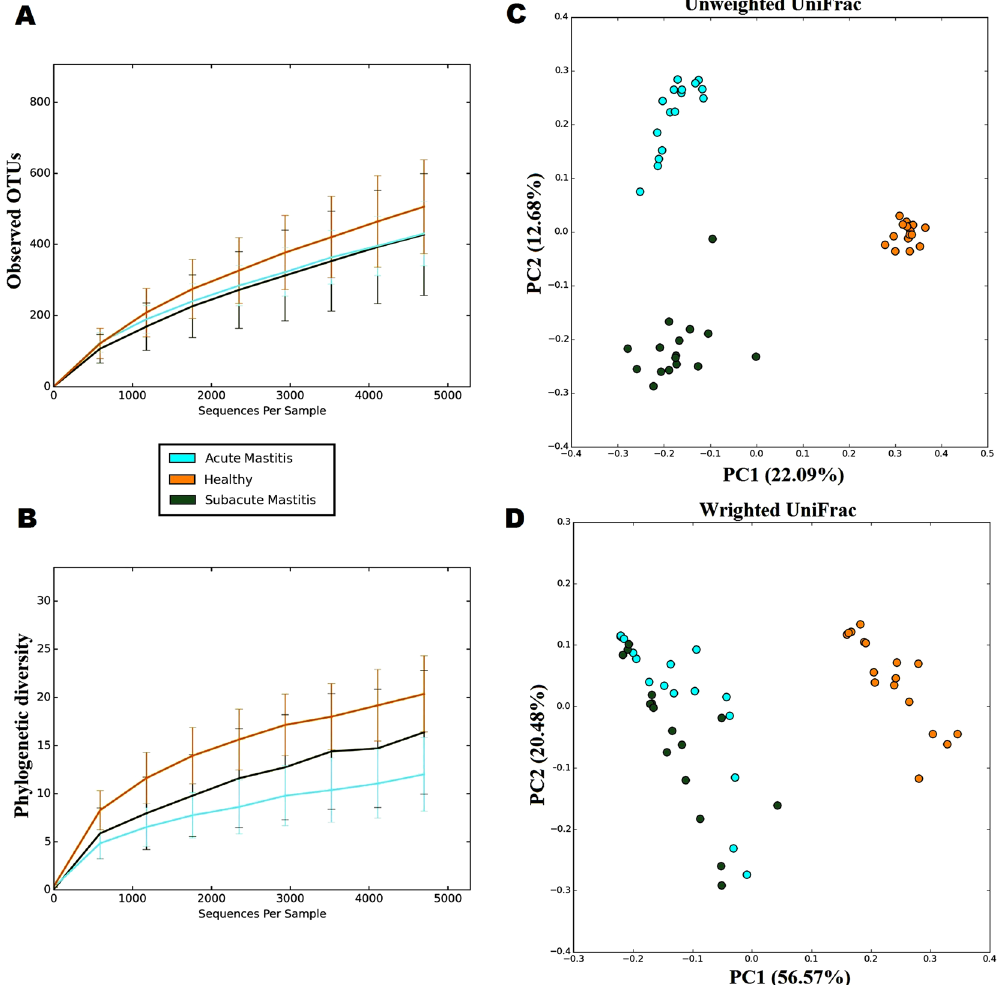
Figure 1. Alpha diversity and beta diversity of breast milk microbiota among healthy-controls, SAM and AM women. Alpha diversity was determined by ( A ) number of observed OTUs and ( B ) Phylogenetic diversity. Beta diversity was accessed by using PCoA of ( C ) unweighted UniFrac and ( D ) weighted UniFrac distance metrices. Clear separation was observed between healthy-controls, SAM and AM